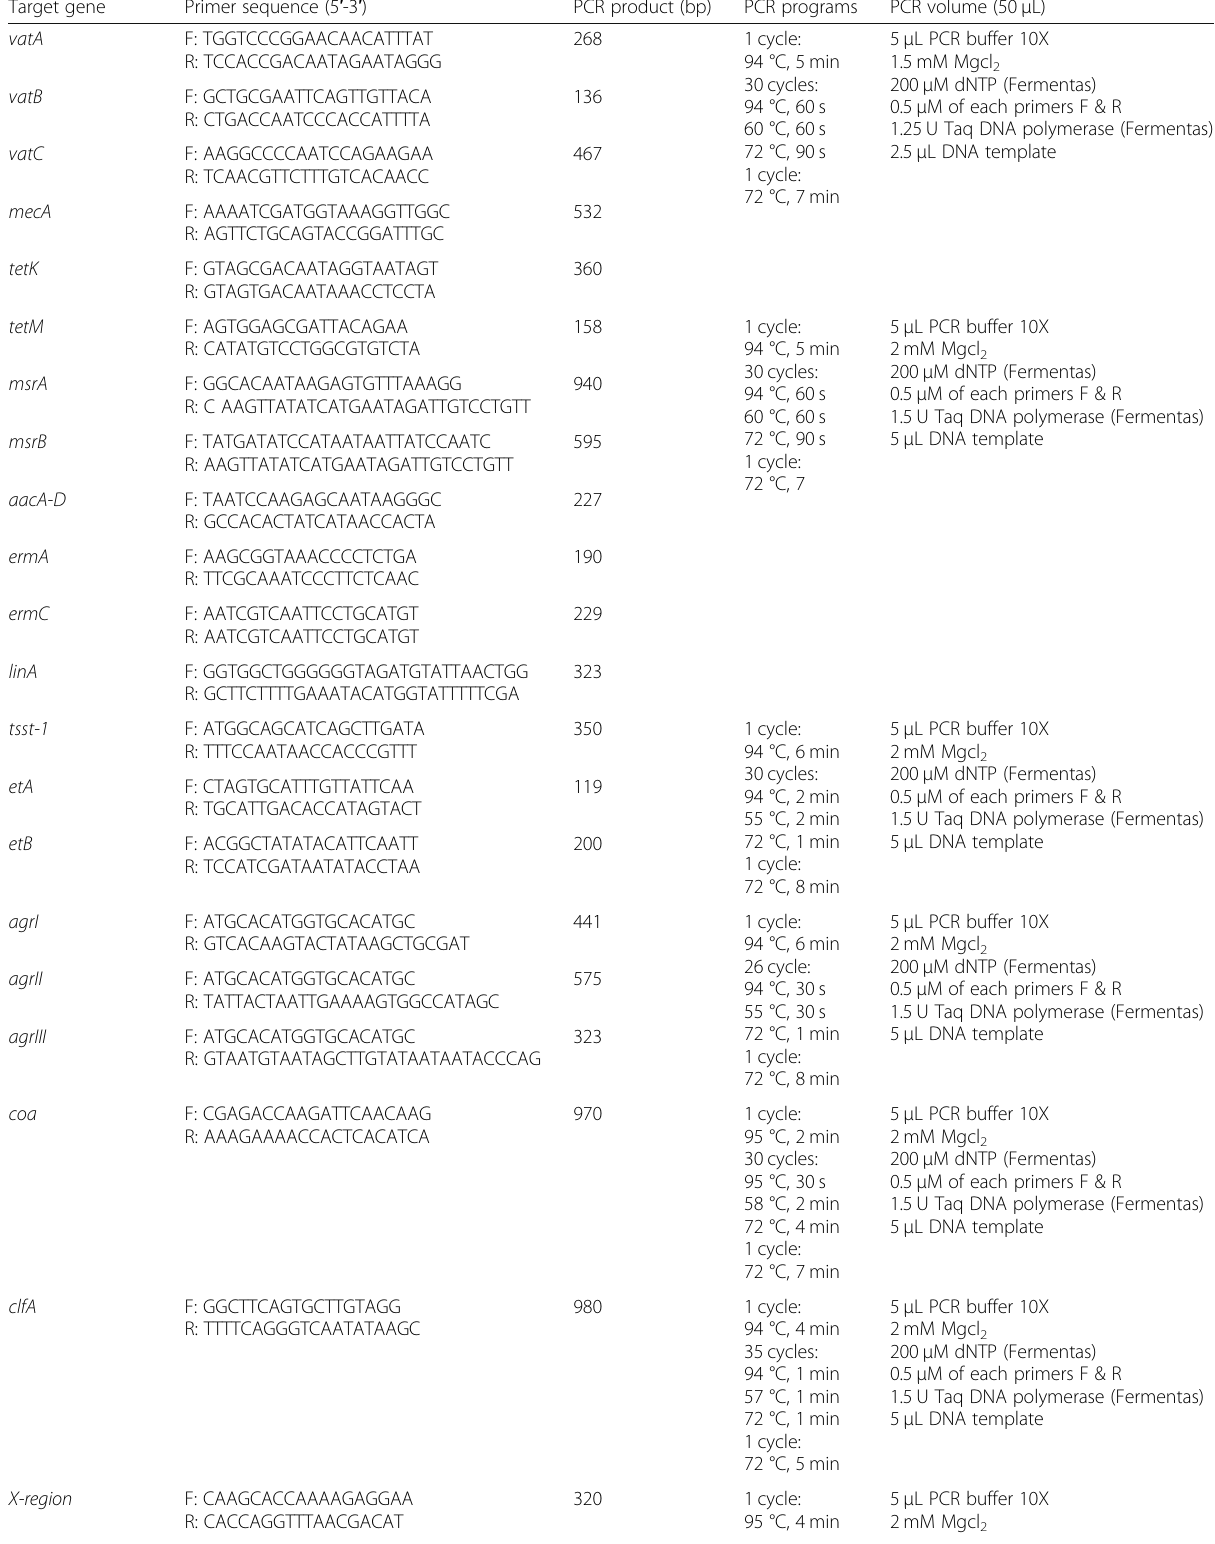
Table 4 Target genes, oligonucleotide primers, and PCR conditions used for the detection of virulence factors and antibiotic resistance genes in the S. epidermidis strains isolated from various types of hospital infectious samples Target gene Primer sequence (5 ′ -3 ′